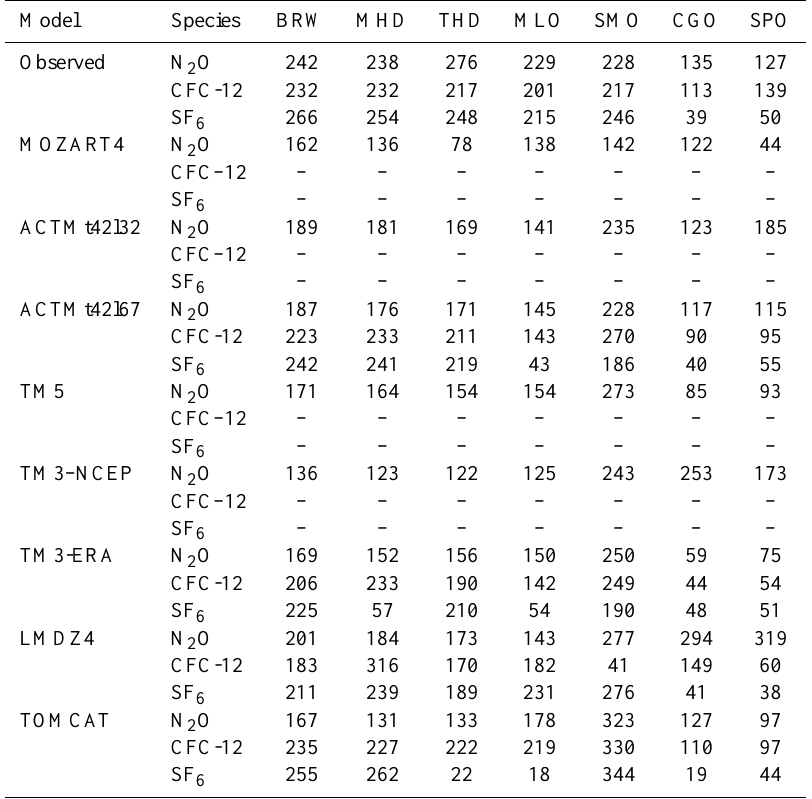
Table 9. Day of the year for the occurrence of the minimum in the mean seasonal cycle (2006–2009) of N 2 O, CFC-12 and SF 6 at each of the background